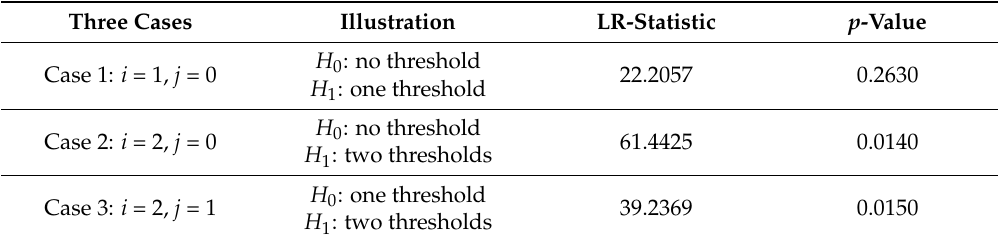
Table 3. Likelihood ratiotest for nonlinear effect.